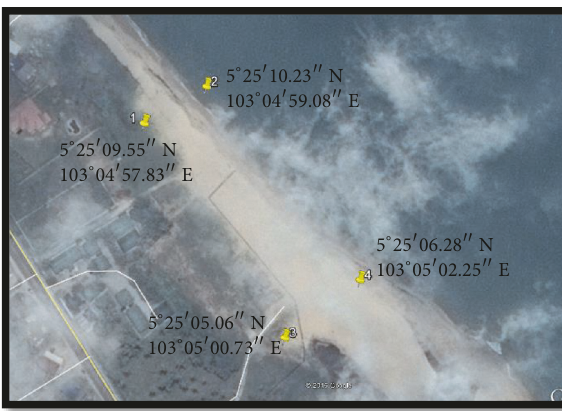
Figure 2: Research methodology.